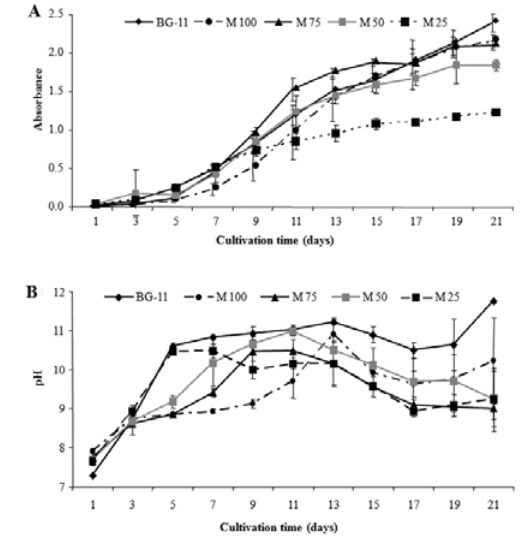
Fig. 2. The growth pattern of Chlorella / Scenedesmus algae culture under different wastewater concentrations (A) and the variation of the pH values (B) during the course of